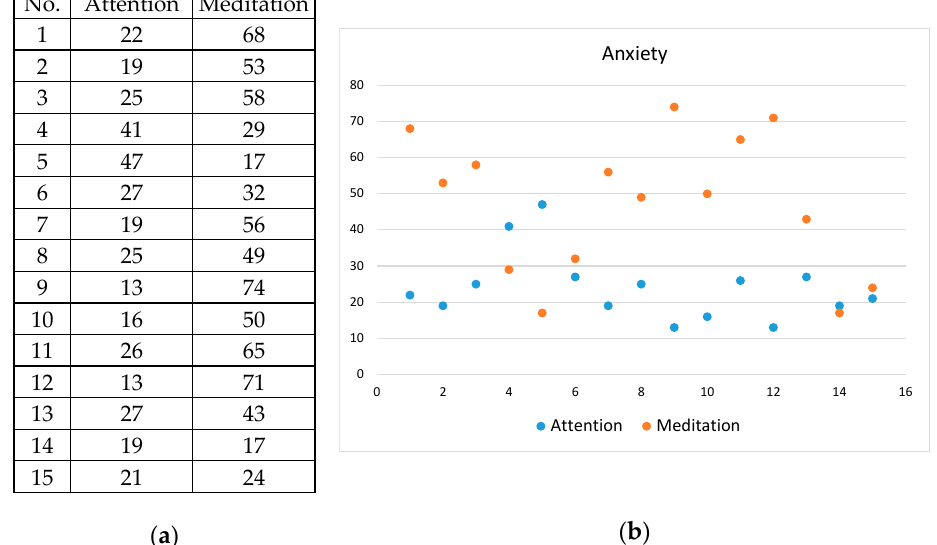
Figure A3. The data and the distribution graph of the average values of the 15 measured two-feature sample sequences of the emotion type of calmness, from which the corresponding decision rule 30 ≤ a < 70 and 30 ≤ m < 70 for emotion classification was inferred, where m and a represent the meditation and attention signals, respectively. ( a ) The average data. ( b ) The distribution graph.